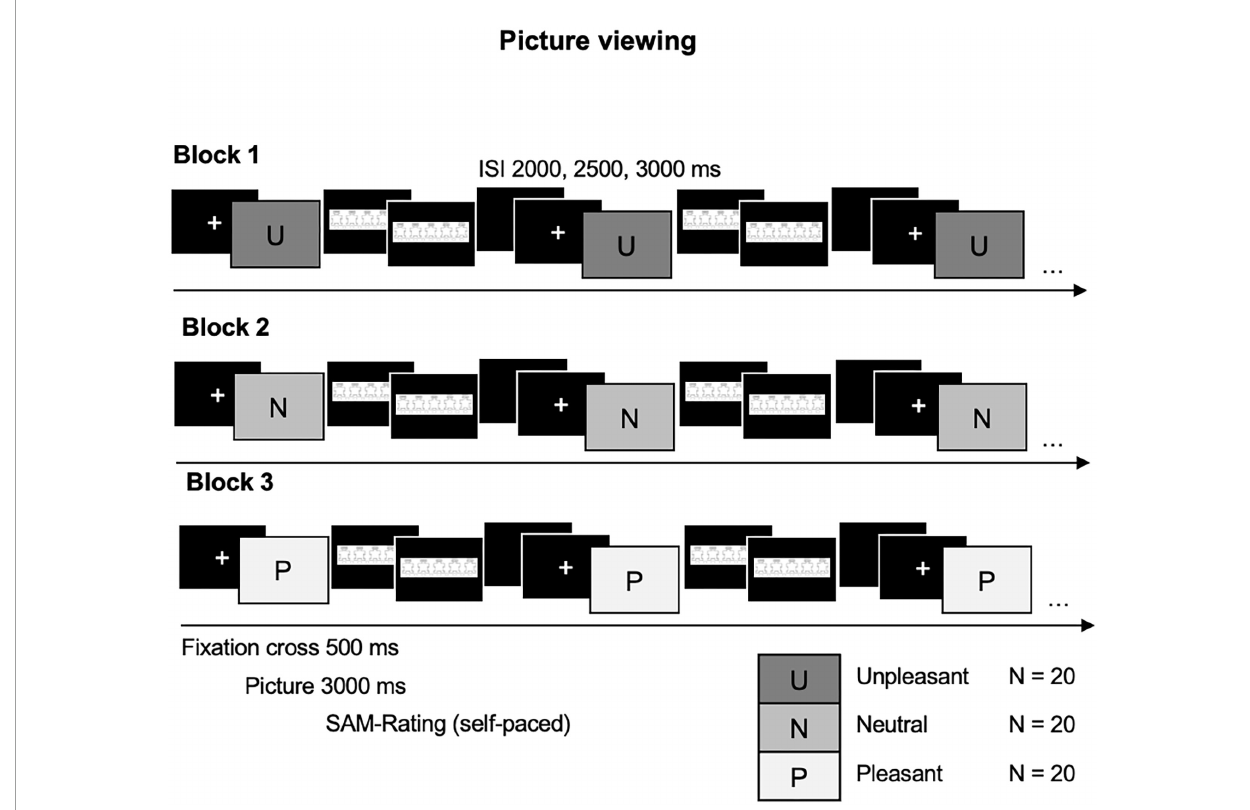
FIGURE1 Picture viewing task. Blocked presentation of unpleasant (U), neutral (N), and pleasant (P) pictures for 3000 ms, following a 500 ms fixation cross; self-paced Self-Assessment Manikin (SAM) ratings follow each picture presentation. Variable inter-stimulus interval (ISI) of 2,500, 3,000, and 3,500 ms.